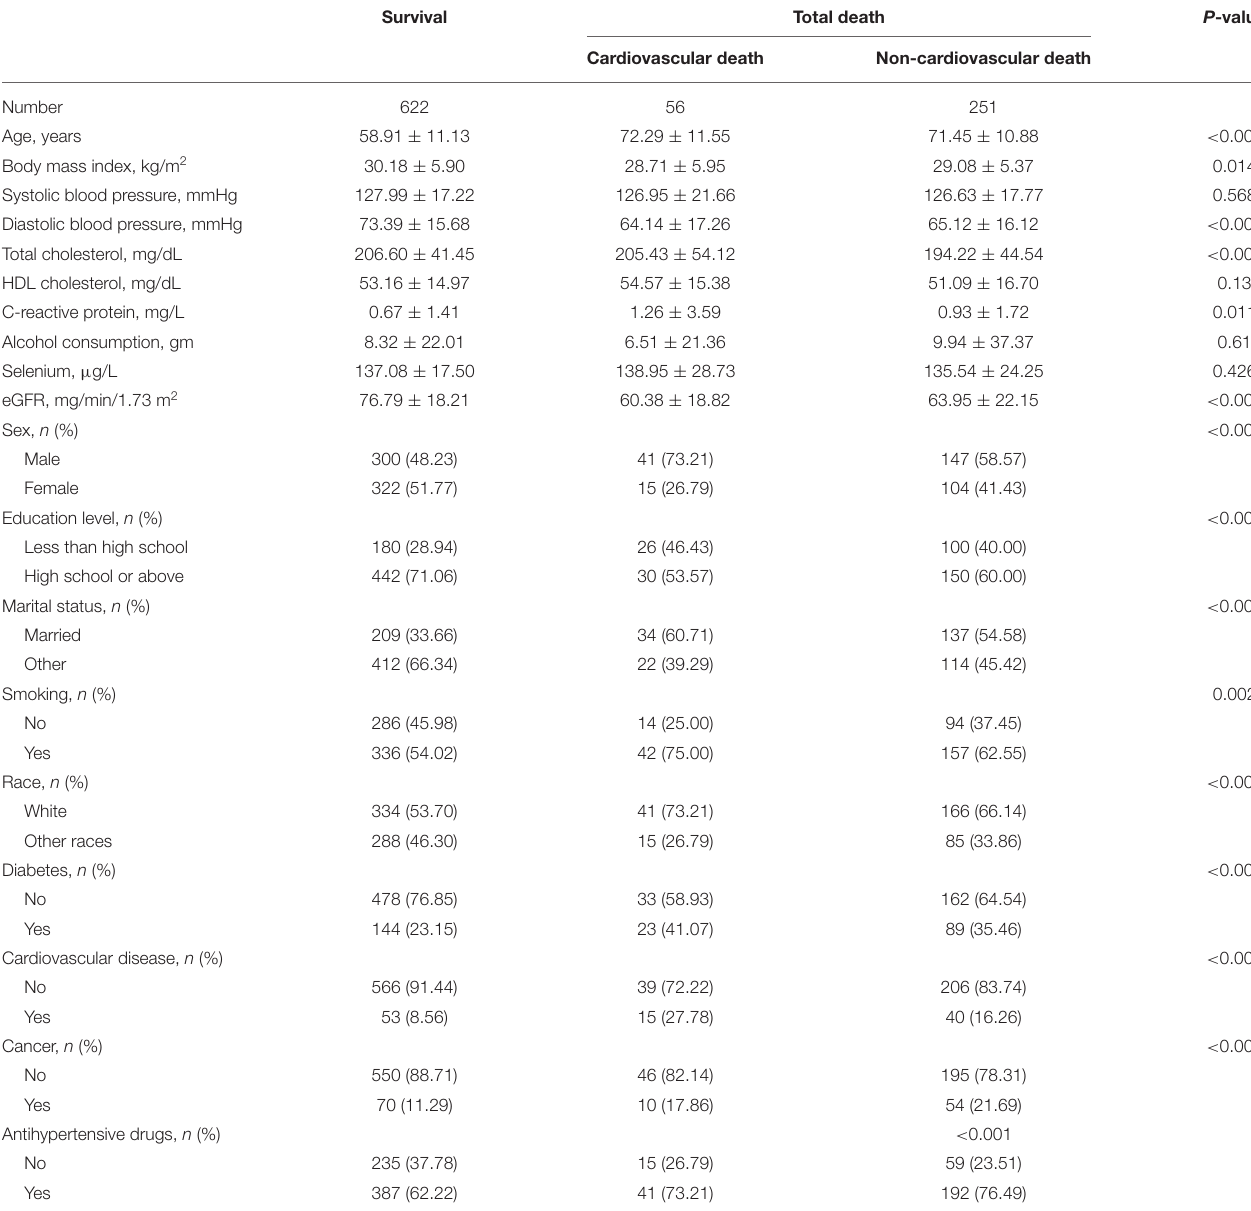
TABLE 2 | Baseline demographic and clinical parameters among participants between mortality and survival group. Survival Total